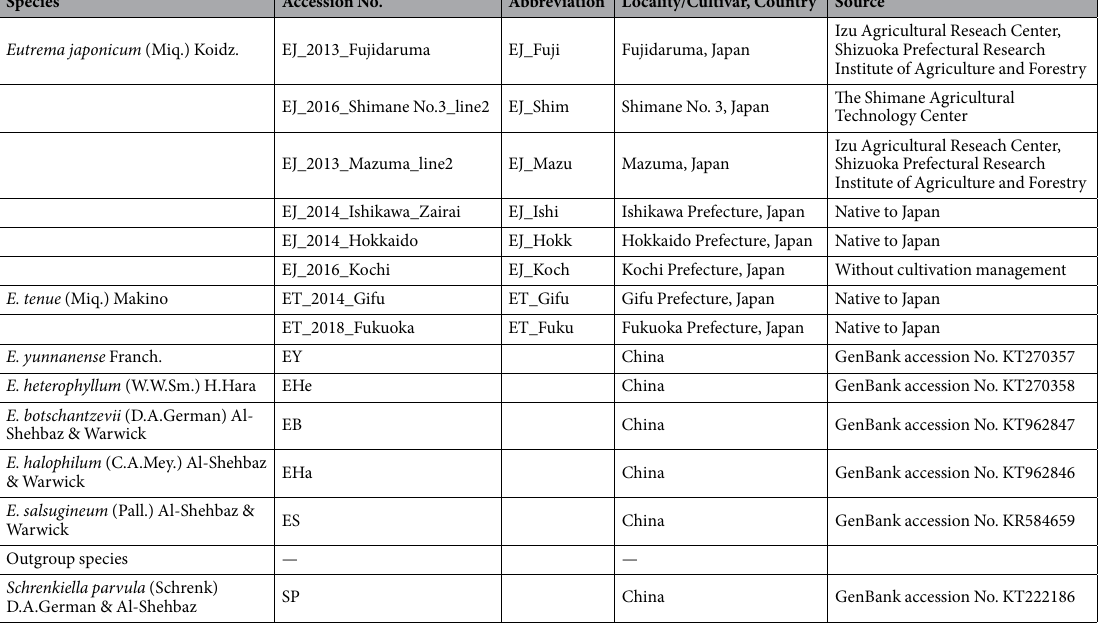
Table 3. Plant materials of Eutrema species used in this